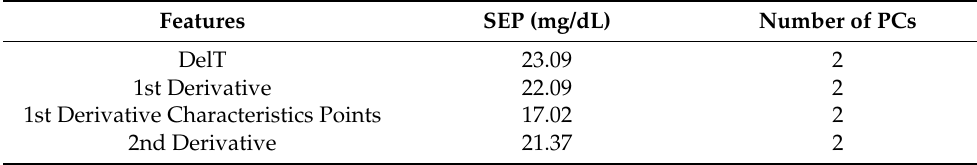
Table 3. Comparison of performances of different PLS